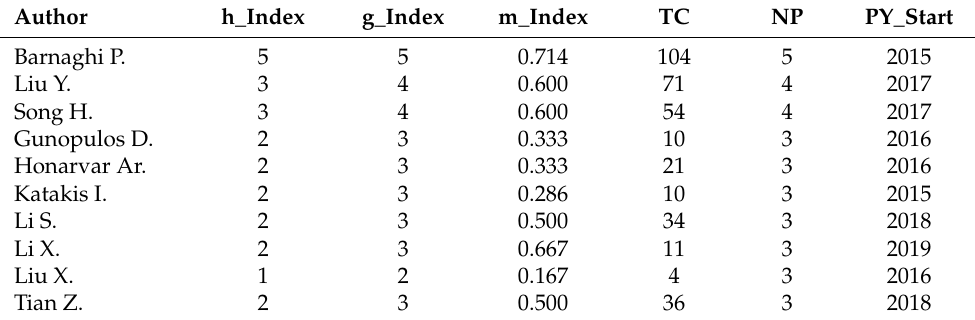
Table 7. Author impact.